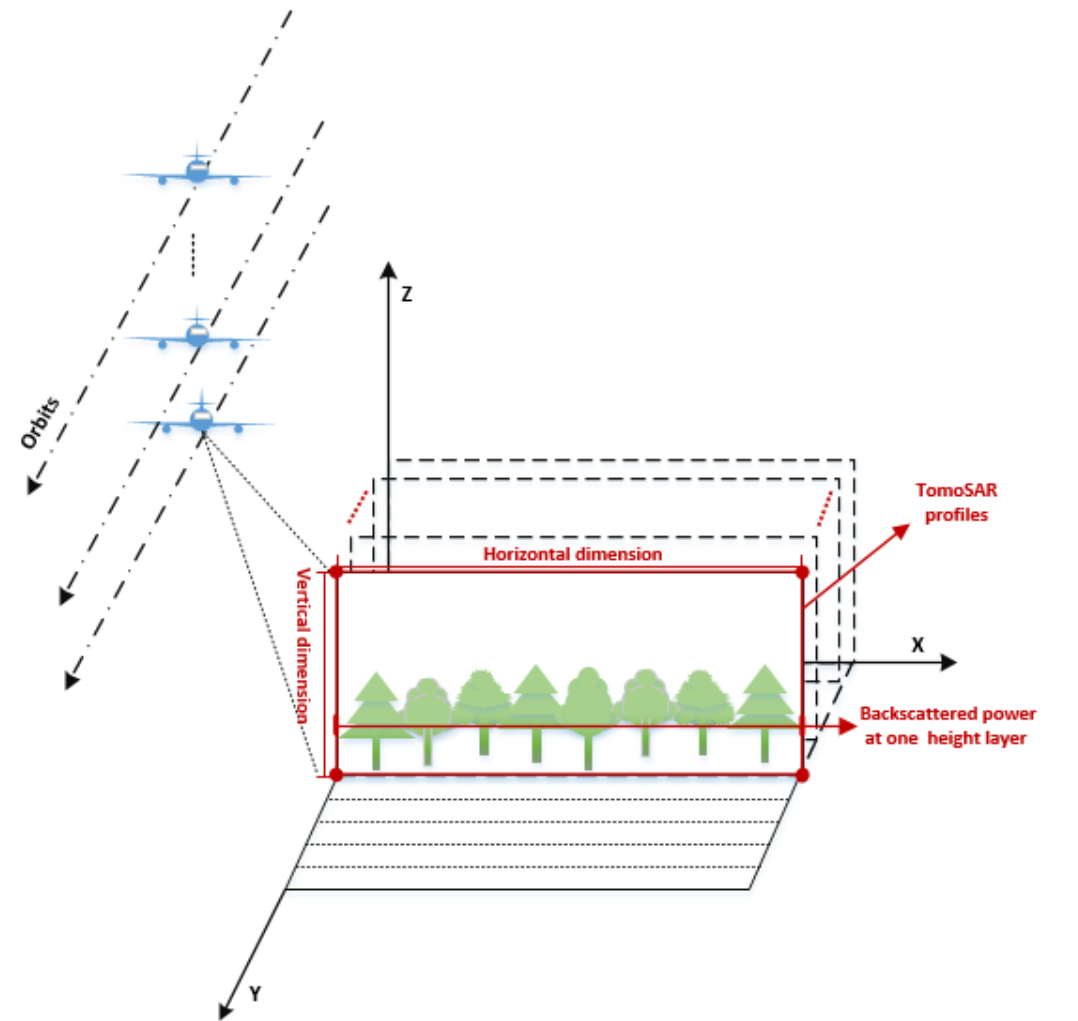
Figure 6. Schematic diagram of forest 3D observation by Tomographic SAR